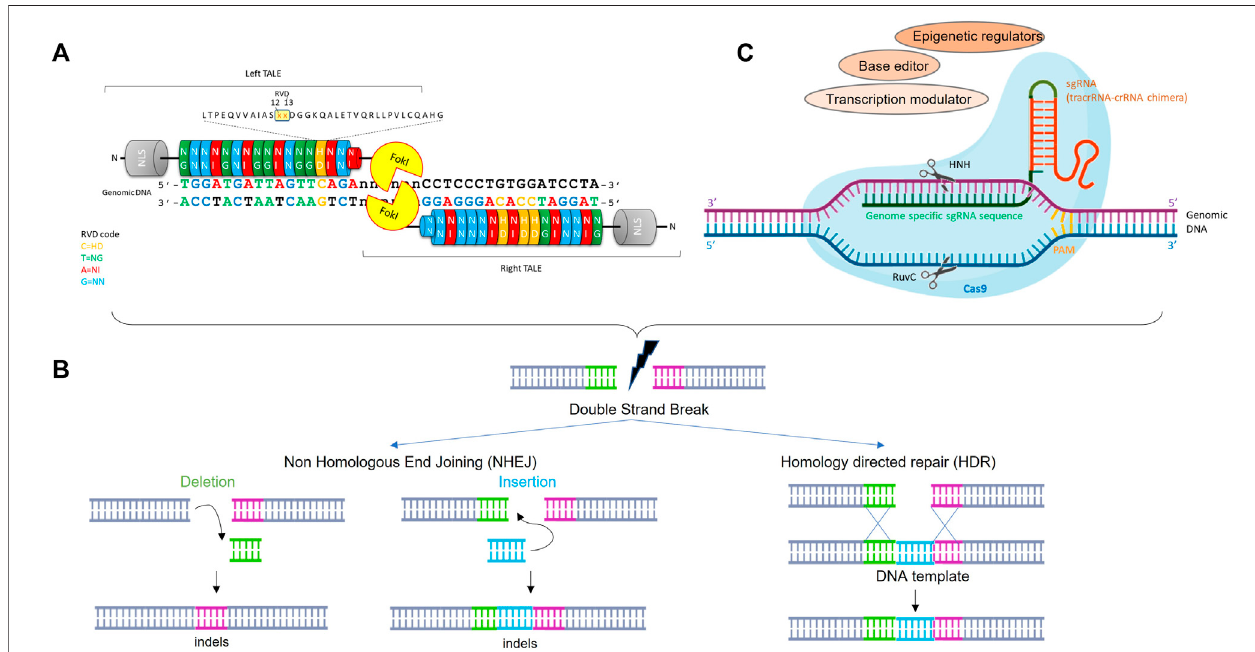
FIGURE 1 | Schematic structure and activity of TALEN and CRISPR/cas9 for genome editing. (A) : TALENs and CRISPR/cas9 are engineered to bind a target sequenceofinterestbyassemblyfromTALErepeatunitsspeci fi ctoeachbasepairorsimplecloningintosgRNAexpressionvector,respectively. (B) :Nuclease-induced genomeediting.Doublestrand breakcanberepaired byNon-homologousendjoining(NHEJ) orhomologydirectedrepair(HDR).NHEJcanleadtosmallinsertionsand deletions (indels) at the DBS site, whereas HDR can lead to more precise mutations from a DNA donor template. (C) : Schematic representation of the CRISPR- Cas9 systemwhereHNH andRuvC represents 2nucleasedomains ofCas9. ThesingleguideRNA(sgRNA)moleculedirectsCas9protein toaspeci fi cDNAtarget.The Cas 9 cleaves genomic DNA upstream to the PAM (Protospacer Adjacent Motif) sequence. The Cas9 can be fused to different modulators or editors to mediate gene expression regulation or base